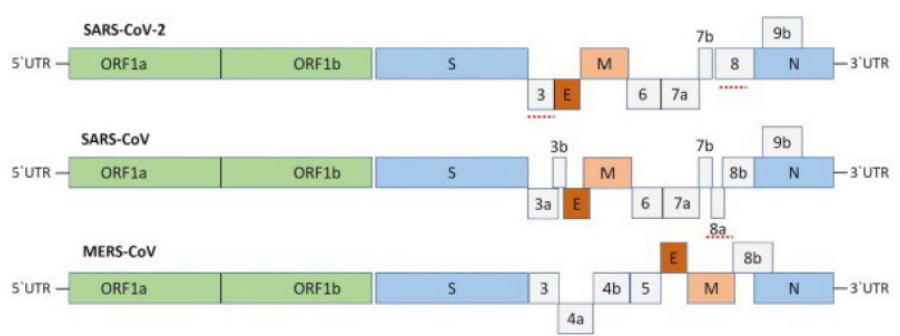
Fig. 1. SARS-CoV2 virus genome chart compared to SARS and MERS coronaviruses